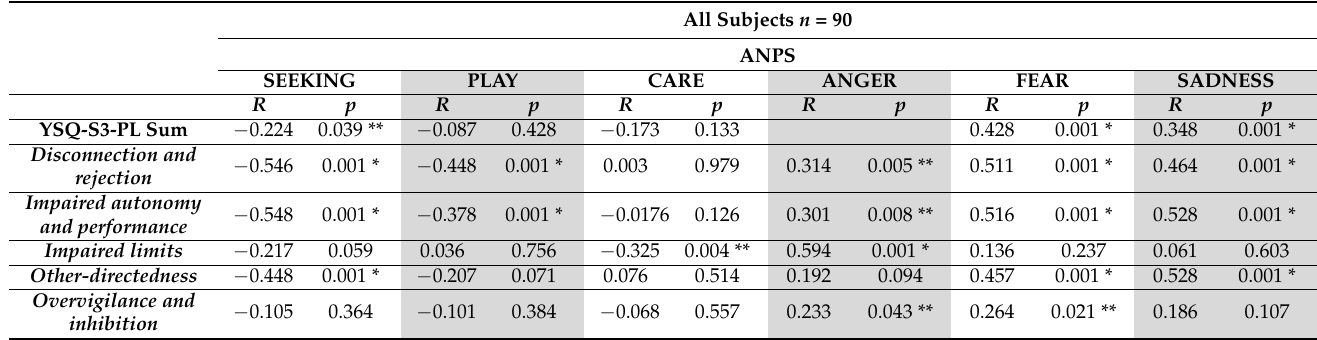
Table 4. Values of Spearman’s rho correlation coefficient for the ANPS scale scores and the five domains of the YSQ-S3-PL questionnaire for the study group ( n = 90).